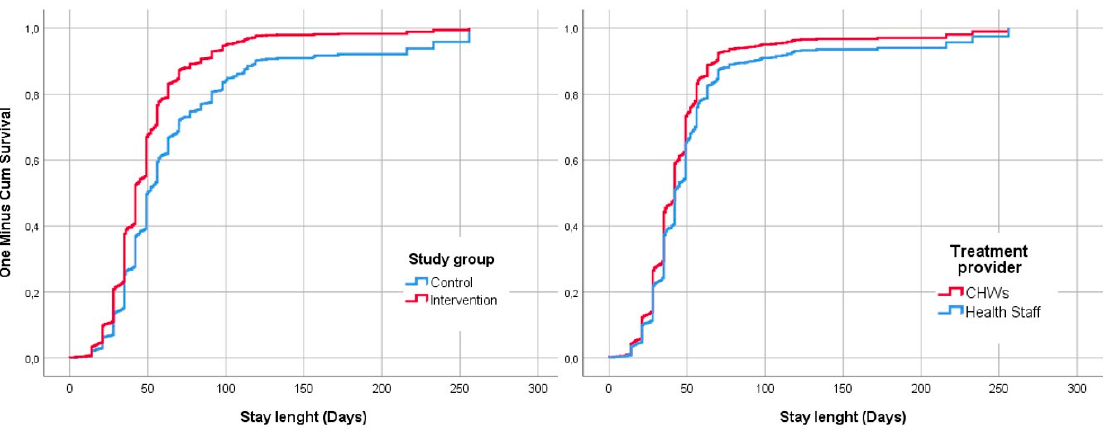
Figure 3. Survival curves for the event recovery adjusted by criteria of admission and compared by study group and treatment provider within the intervention group.